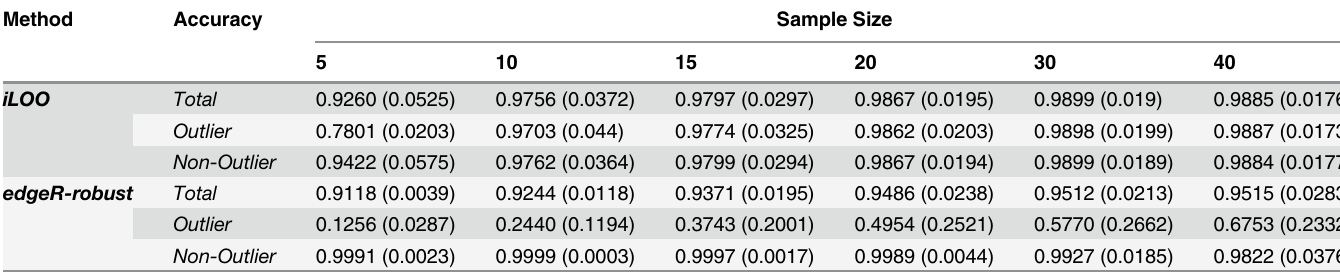
Table 2. Mean (standard deviation) of accuracy metrics from simulated RNA-seq data comparing iLOO (using edgeR normalized sequencing depths) to edgeR-robust .